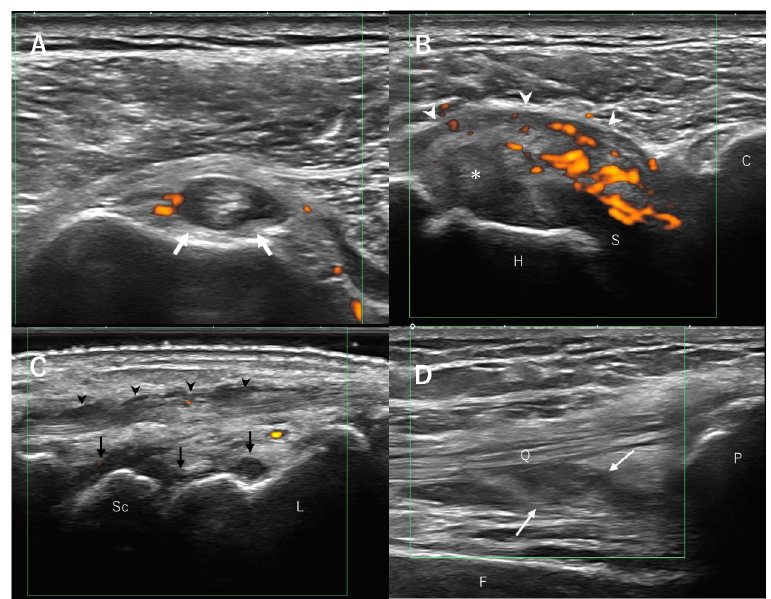
Fig 3. Musculoskeletal ultrasound images of the patient with polyarthritis induced by immuno-checkpoint inhibitors. A. Transverse imaging over the bicipital groove of the right humerus shows tenosynovitis of the long head of the biceps brachii (arrows) with moderate effusion and synovial hypertrophy within the tendon sheath. B. Transverse imaging over the right humeral lesser tuberosity shows prominent power Doppler signals extending from beneath the coracoid process over the subscapularis. The subdeltoid bursitis (arrowheads) and the swelling of the long head of the biceps brachii within the rotator interval (asterisk) can be seen. C. Sagittal imaging over the right dorsal wrist shows synovial hypertrophy at the dorsal recesses of the radiocarpal and midcarpal joints (black arrows). Tendinitis surrounding the extensor tendon can be seen (arrows). D. Sagittal imaging of the anterior knee shows hypoechoic to isoechoic synovial hypertrophy within the suprapatellar recess (arrows). H, humeral head; S, subscapularis; C, coracoid process; Sc. Scaphoid; L, lunate; F, femur; P, patella; Q, quadriceps